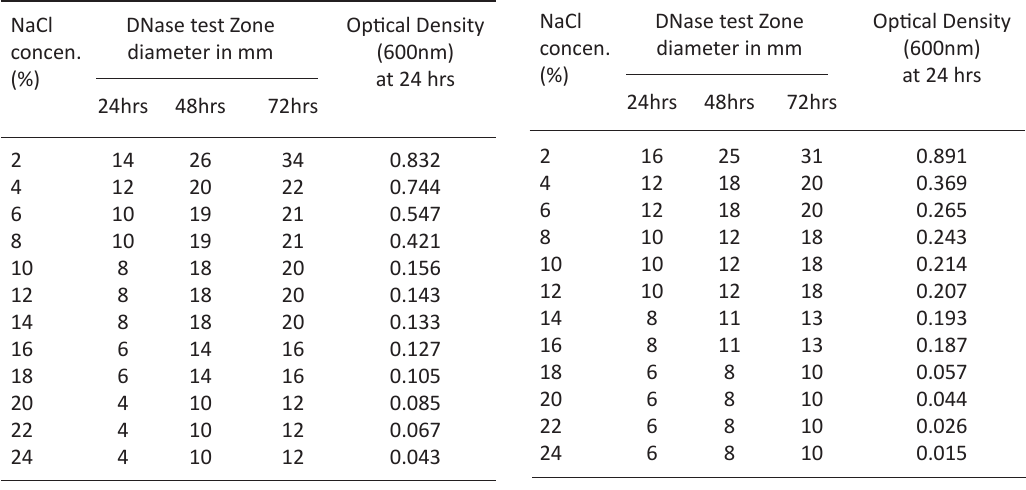
Table 3. DNase production of selected bacterial isolates on DNase test agar Bacterial DNase Test Isolates Zone diameter in mm 24hrs 48hrs 72hrs KVCMST 6A 20 14 26 34 KVCMST 6A 23 16 KVCMST 7A 6 KVCMST 8A 12 Table 4. DNase production for KVCMST-6A20 at various NaCl concentrations on DNase test agar NaCl DNase test Zone Optical Density concen. diameter in mm (%)